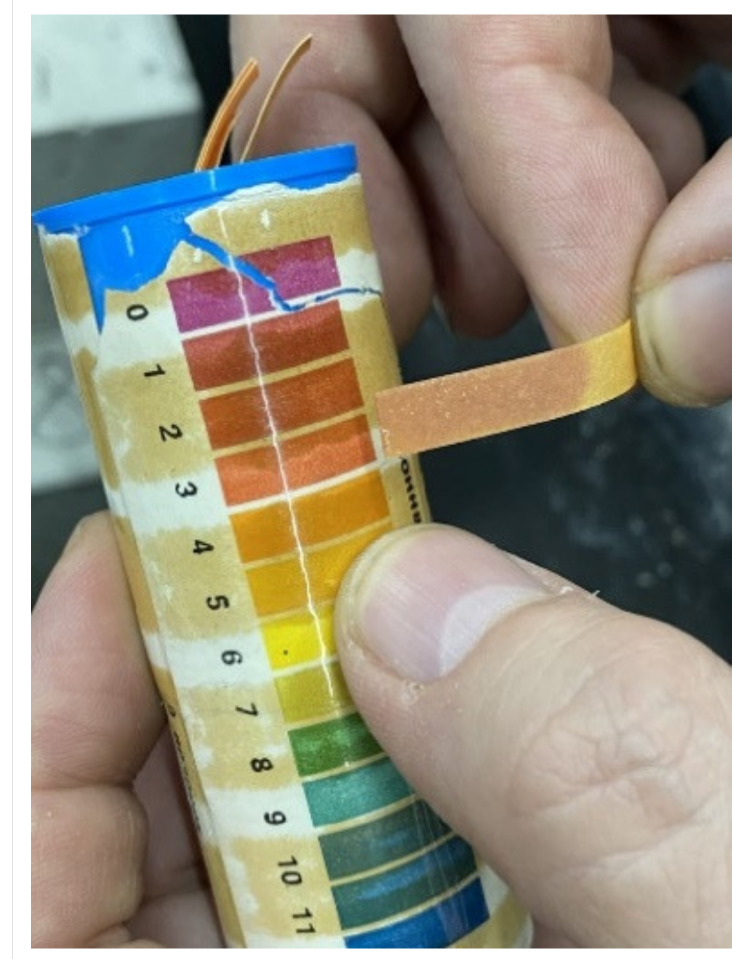
Figure 9. Acid environment test, pH =